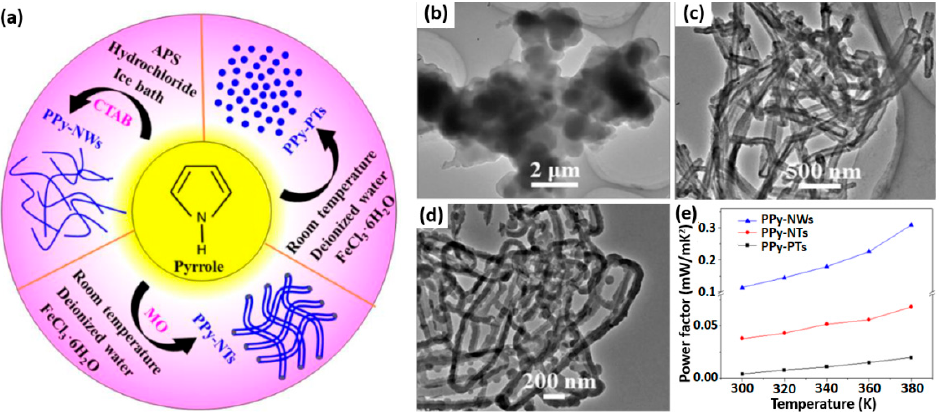
Figure 7. ( a ) Schematic illustration of the formation procedure of PPy nanoparticles (PTs), nanotubes (NTs) and nanowires (NWs). TEM images of ( b ) PPy-PTs, ( c ) PPy-NTs and ( d ) PPy-NWs. ( e ) Thermoelectric power factor of PPy-PTs, PPy-NTs and PPy-NWs. Readapted with permission from MDPI [72].